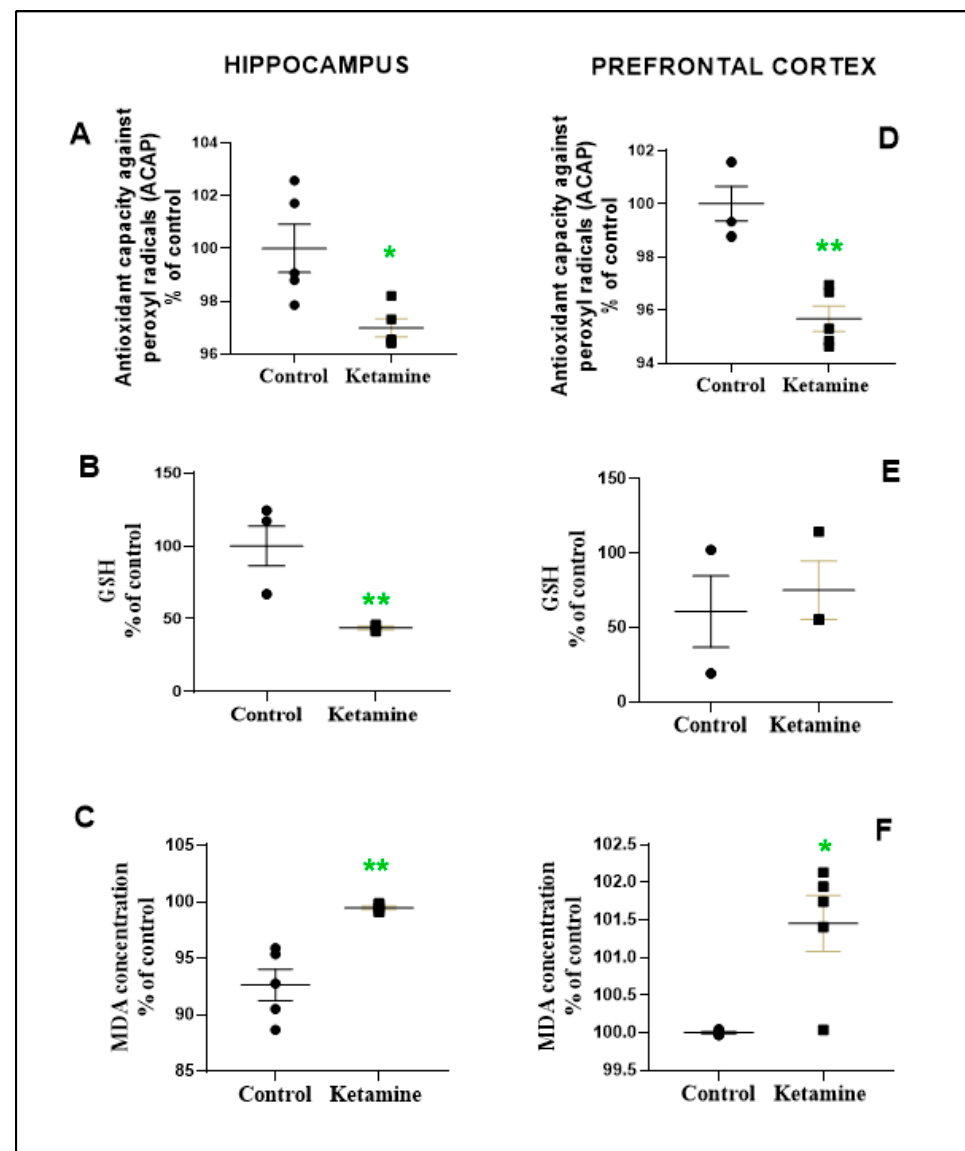
Figure 5. Effects of ketamine recreational regimen (10 mg/kg/day for 3 days, i.p) or saline (control group) in the early withdrawal (24 h) stage on oxidative balance parameters on hippocampus ( A – C ) and prefrontal cortex ( D – F ) of adolescent female Wistar rats ( n = 3–5 animals/group). Panel ( A , D ): Antioxidant Capacity Against Radicals Peroxyl (ACAP); panel B and E: Reduced glutathione (GSH); panel C and F: malondialdehyde (MDA). Results were normalized by protein content and expressed as percentual of control group. * p < 0.05 compared to control group; ** p < 0.01 compared to control group. Mann–Whitney